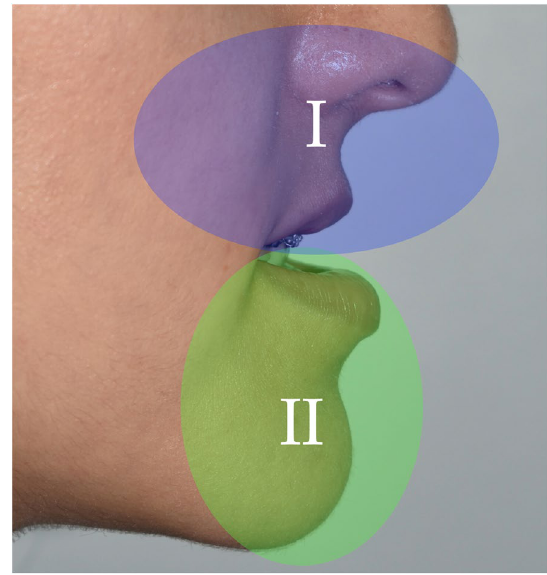
Fig. 5 Lip balance is an important aesthetic component that falls between zones I and